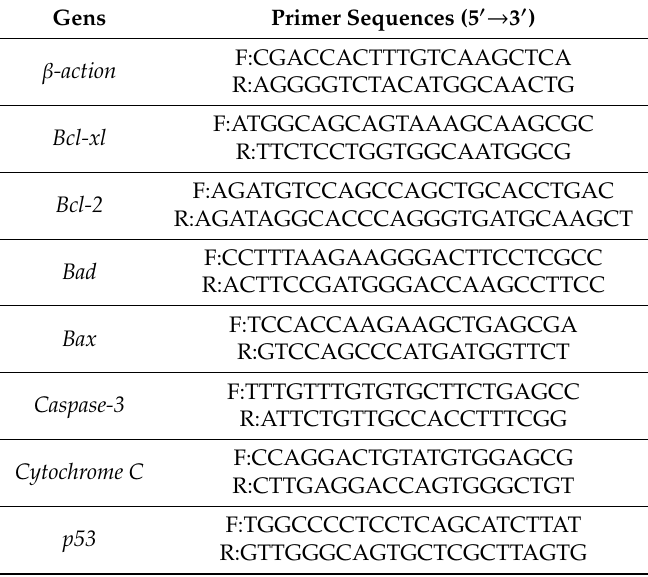
Table 1. Sequences of primers used in real-time